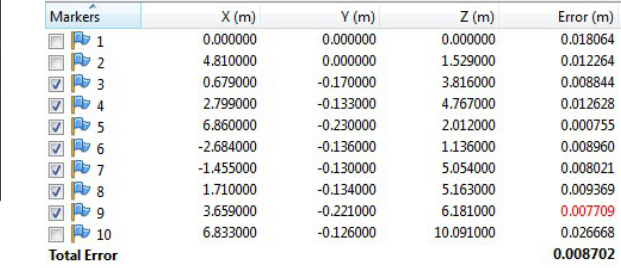
Table 9. GRP and GCP imported into “Agisoft – PhotoScan Pro”, used to scale the model and to assess the